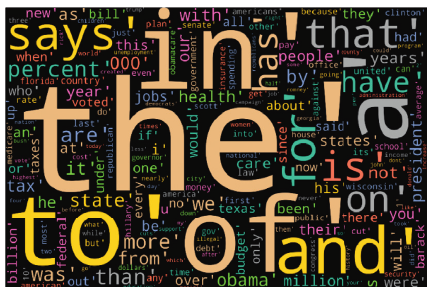
Figure 5: Word cloud before preprocessing.